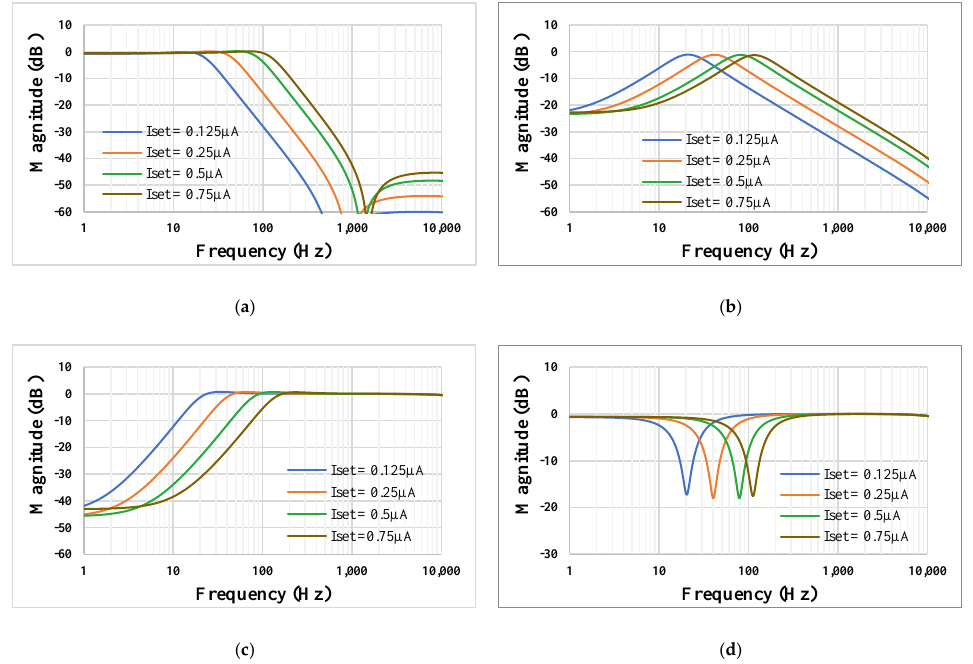
Figure 14. Magnitude characteristics showing the tuning capability of the LPF ( a ), BPF ( b ), HPF ( c ), and BSF ( d ) with different bias currents .